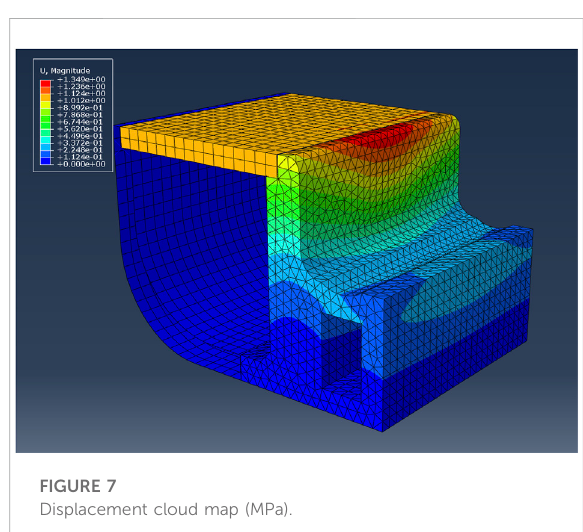
FIGURE 7 Displacement cloud map